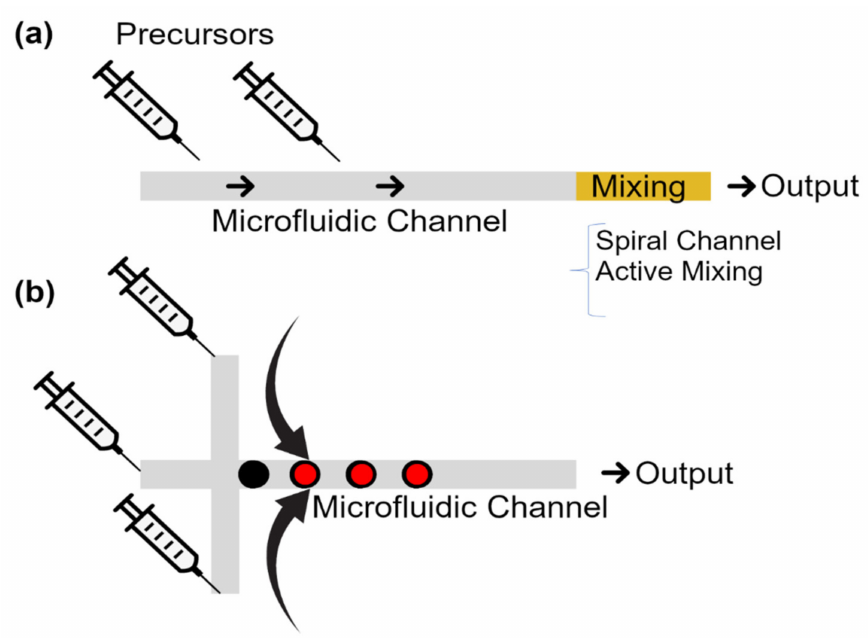
Figure 1. The two main methods of microfluidic-based nanoparticle synthesis. ( a ) Continuous-flow microreactors, where the particles are synthesized in a microchannel, and ( b ) the droplet-based microreactor, where the nanoparticles are synthesized in a droplet. The yellow area (mixing) in ( a ) is optional.